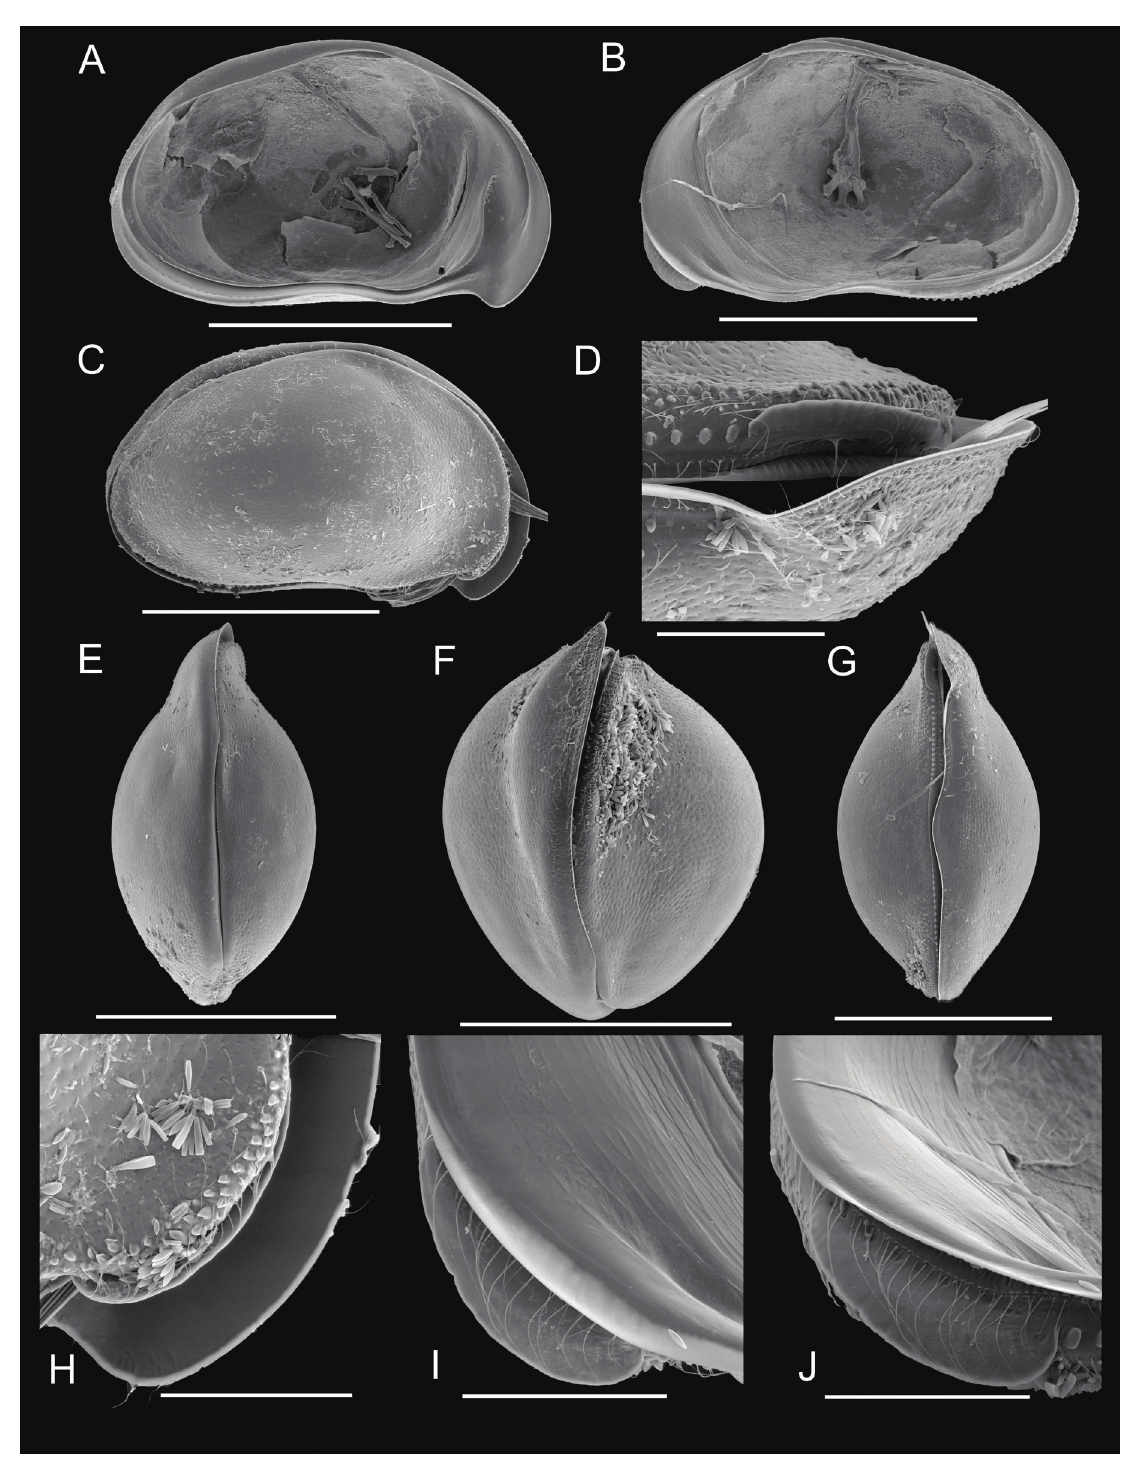
Fig. 15. Bennelongia gwelupsensis sp. nov. (all ♀, from Lake Gwelup, Perth – type locality). A . LVi (holotype ♀, WAM.C49394). B . rVi (Idem). C . Cp rL (WAM.C49395A). D . CpV (detail anteriorly, WAM.C49395B). E . CpD (WAM.C49395C). F . Cp anteriorly (animal inverted) (WAM. C49395D). G . CpV (WAM.C49395B), H . CprL (detail anteriorly, WAM.C49395A). I . rVi (detail anteriorly, holotype ♀, WAM.C49394). J . rVi (detail anteriorly, tilted, Idem). Scales: A-C, E,G = 1000 µm; F = 500 µm; D,H-J = 200